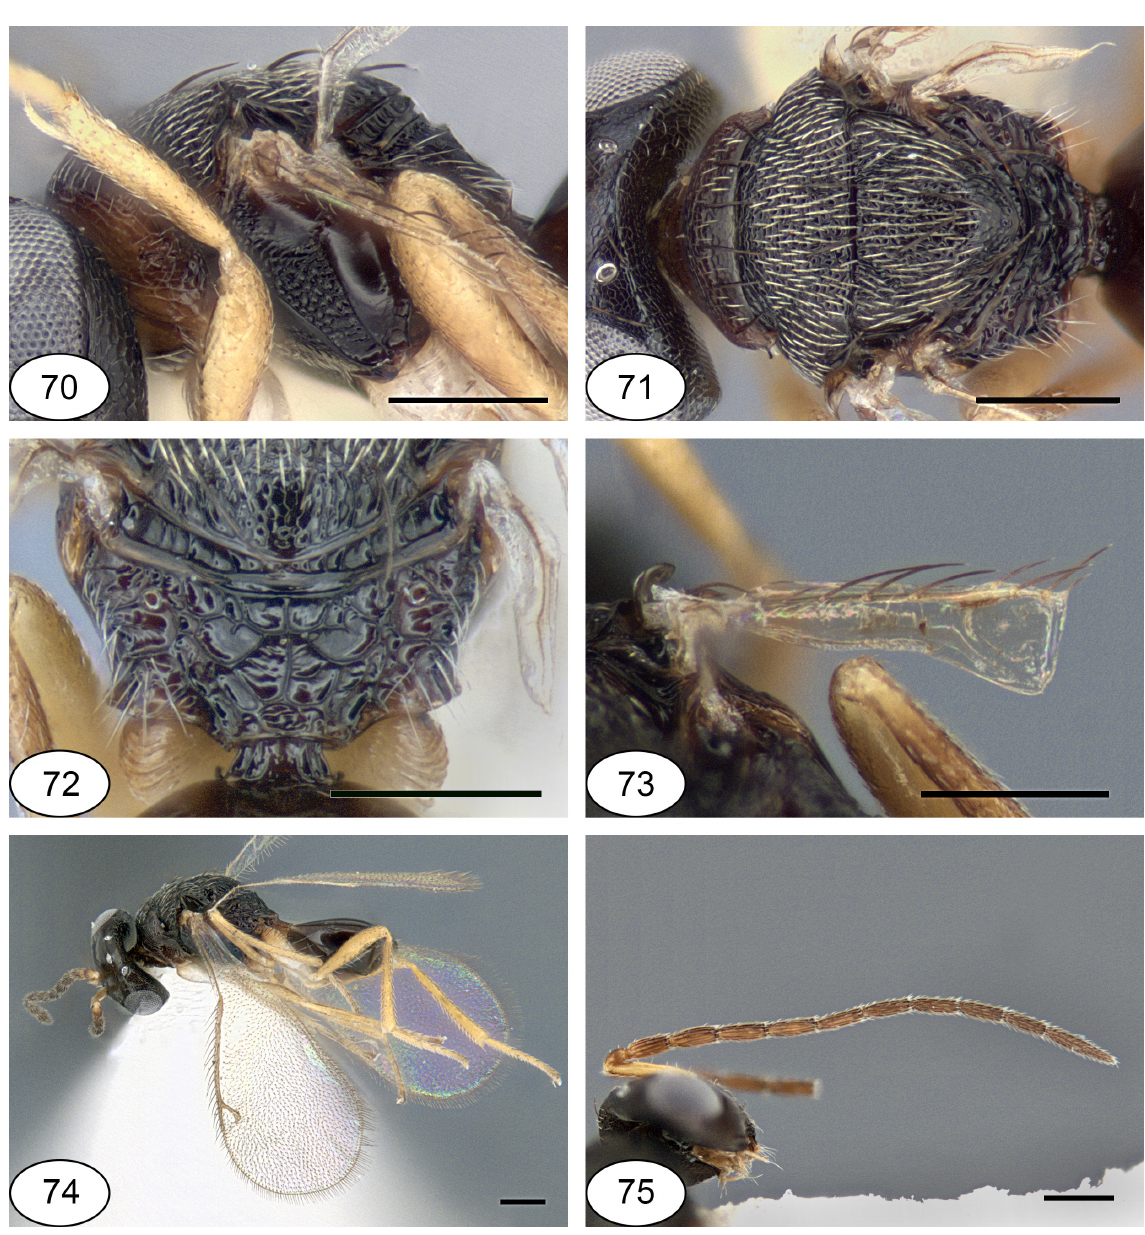
Figs 70–75. Netomocera formiciformis sp. nov. 70 . Holotype, ♀, mesosoma, lateral view. 71 . Holotype, ♀, mesosoma, dorsal view. 72 . Holotype, ♀, propodeum, dorsal view. 73 . Holotype, ♀, fore wing. 74 . Allotype, ♂, habitus, lateral view. 75 . Allotype, ♂, antenna. Scale bars: 0.2